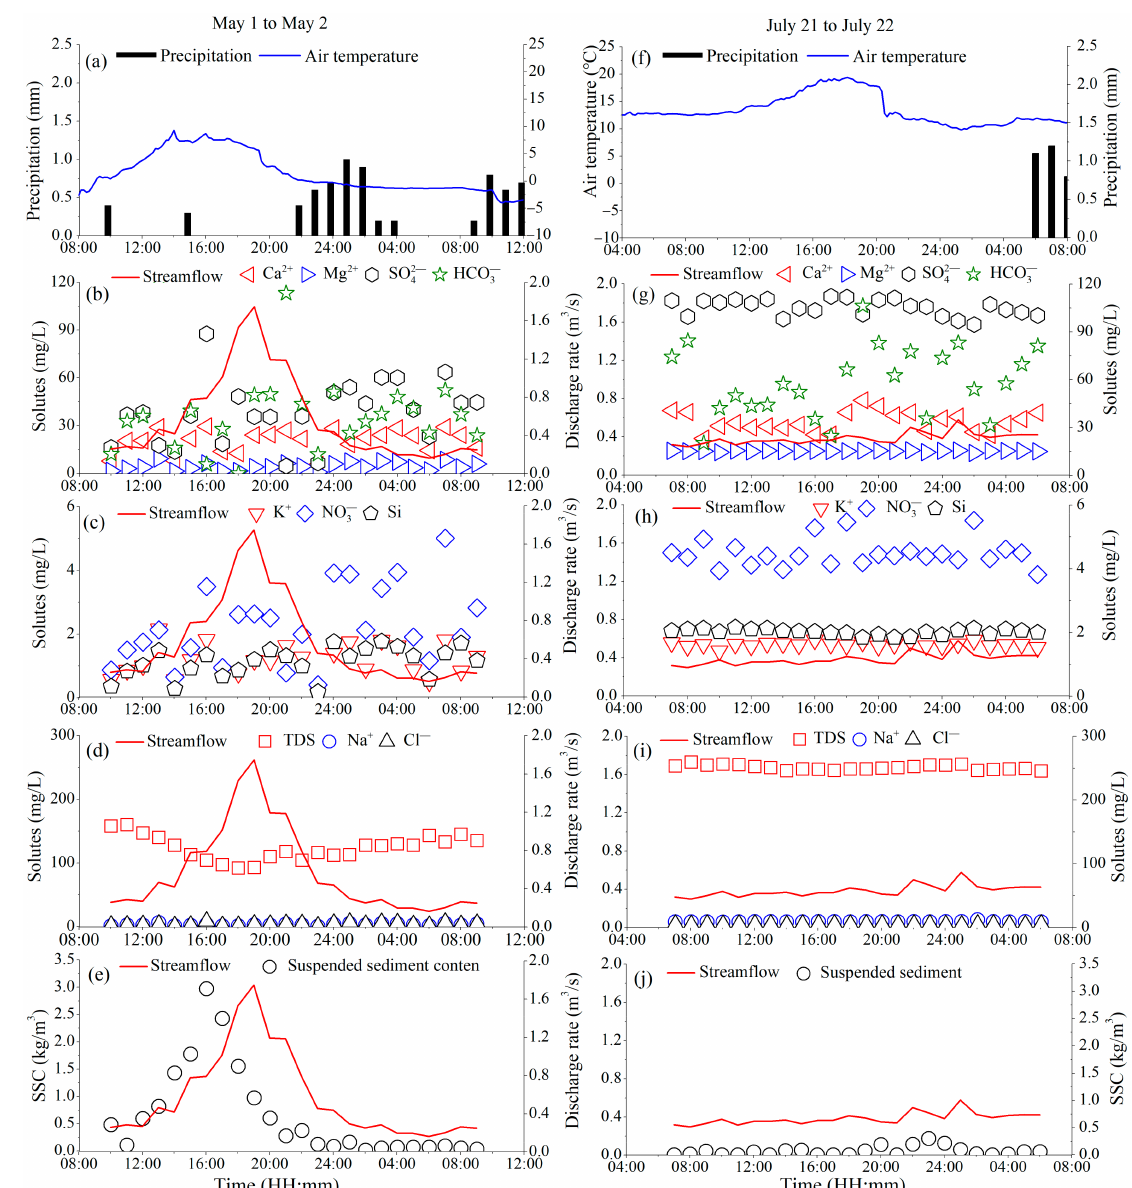
Figure 5. The variation of air temperature and precipitation ( a , f ), streamflow discharge ( b – e , g – j ), suspended sediment content ( e , j ), total dissolved solids (TDS) ( d , i ), and major ions content ( b – d , g – i ) at the outlet of the Binggou catchment during spring (left panels) and summer (right panels) intensive 24 h